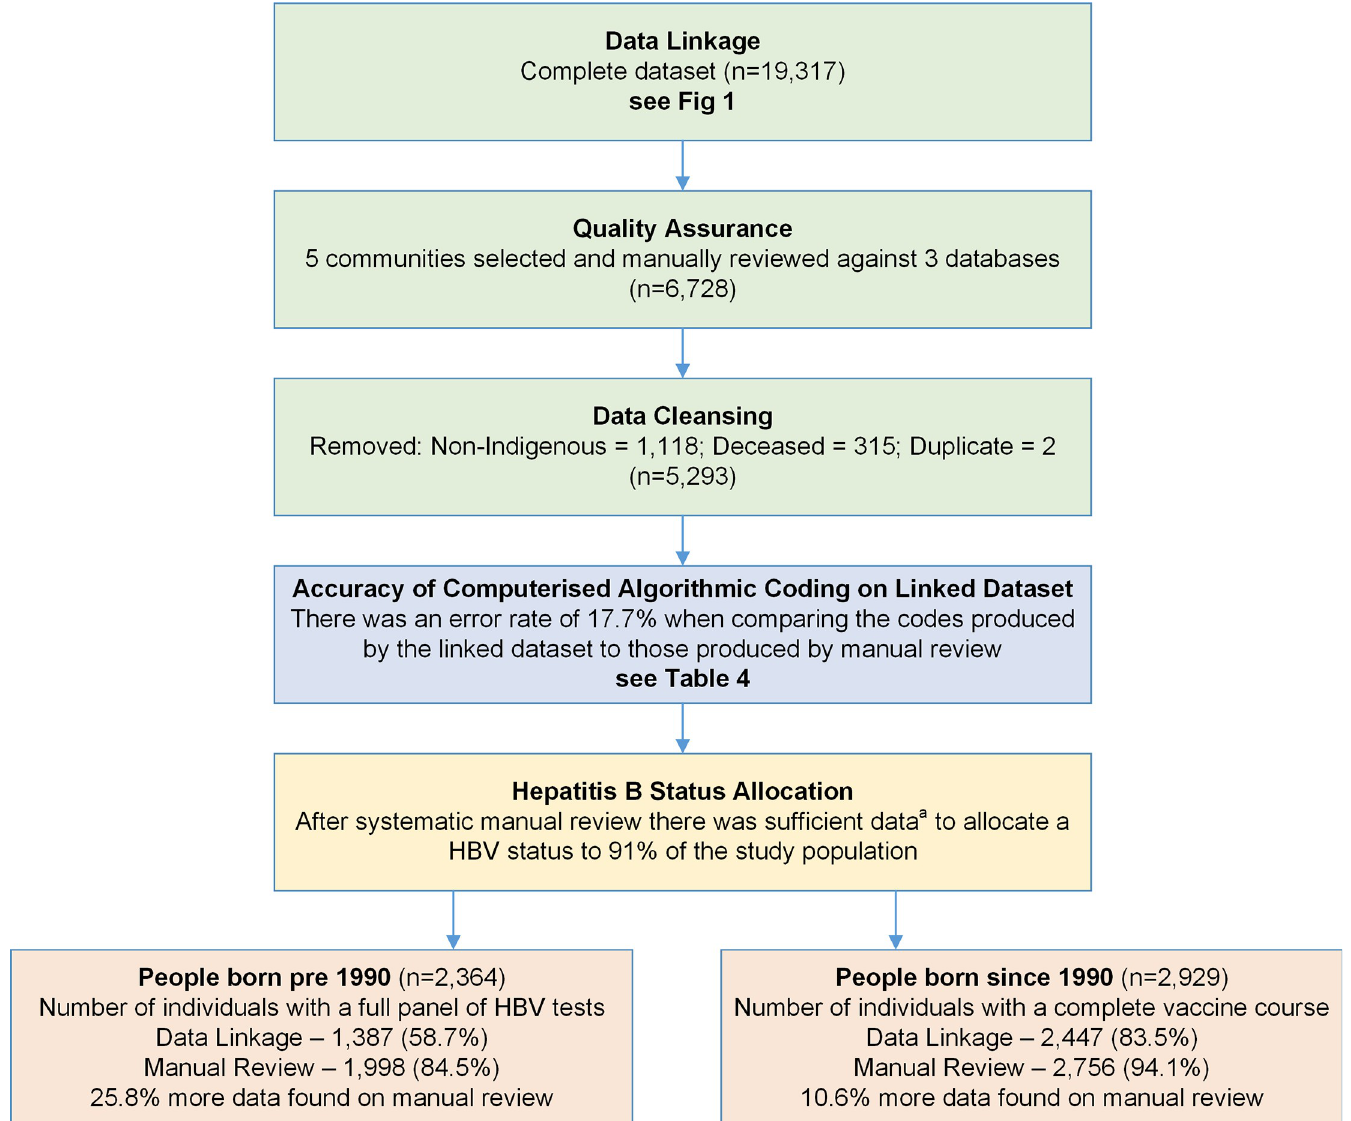
Fig 3. Quality assurance on code generated by computerised algorithm on linked dataset. a Suffient data is defined as full panel of HBV tests for people born before 1990 and all people born since 1990 is 3 documented vaccination, given at correct intervals (+/- HBV test data).